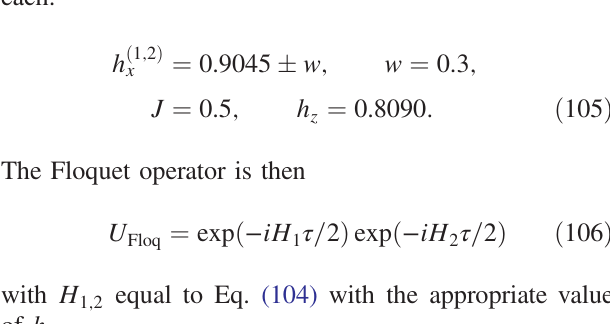
t Þ in Eq. (107) for the two-site x ð